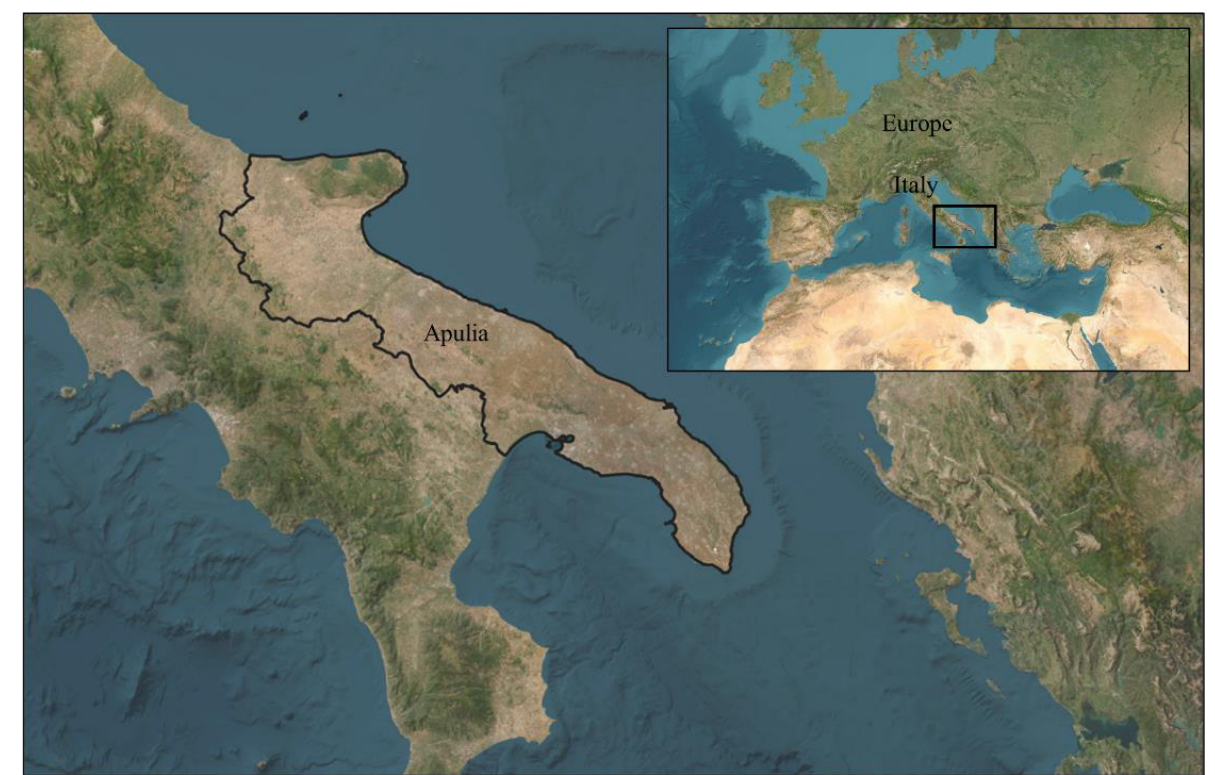
Figure 1. The European geographic location of the study area — Apulia region (southern Italy). Source: our elaboration.